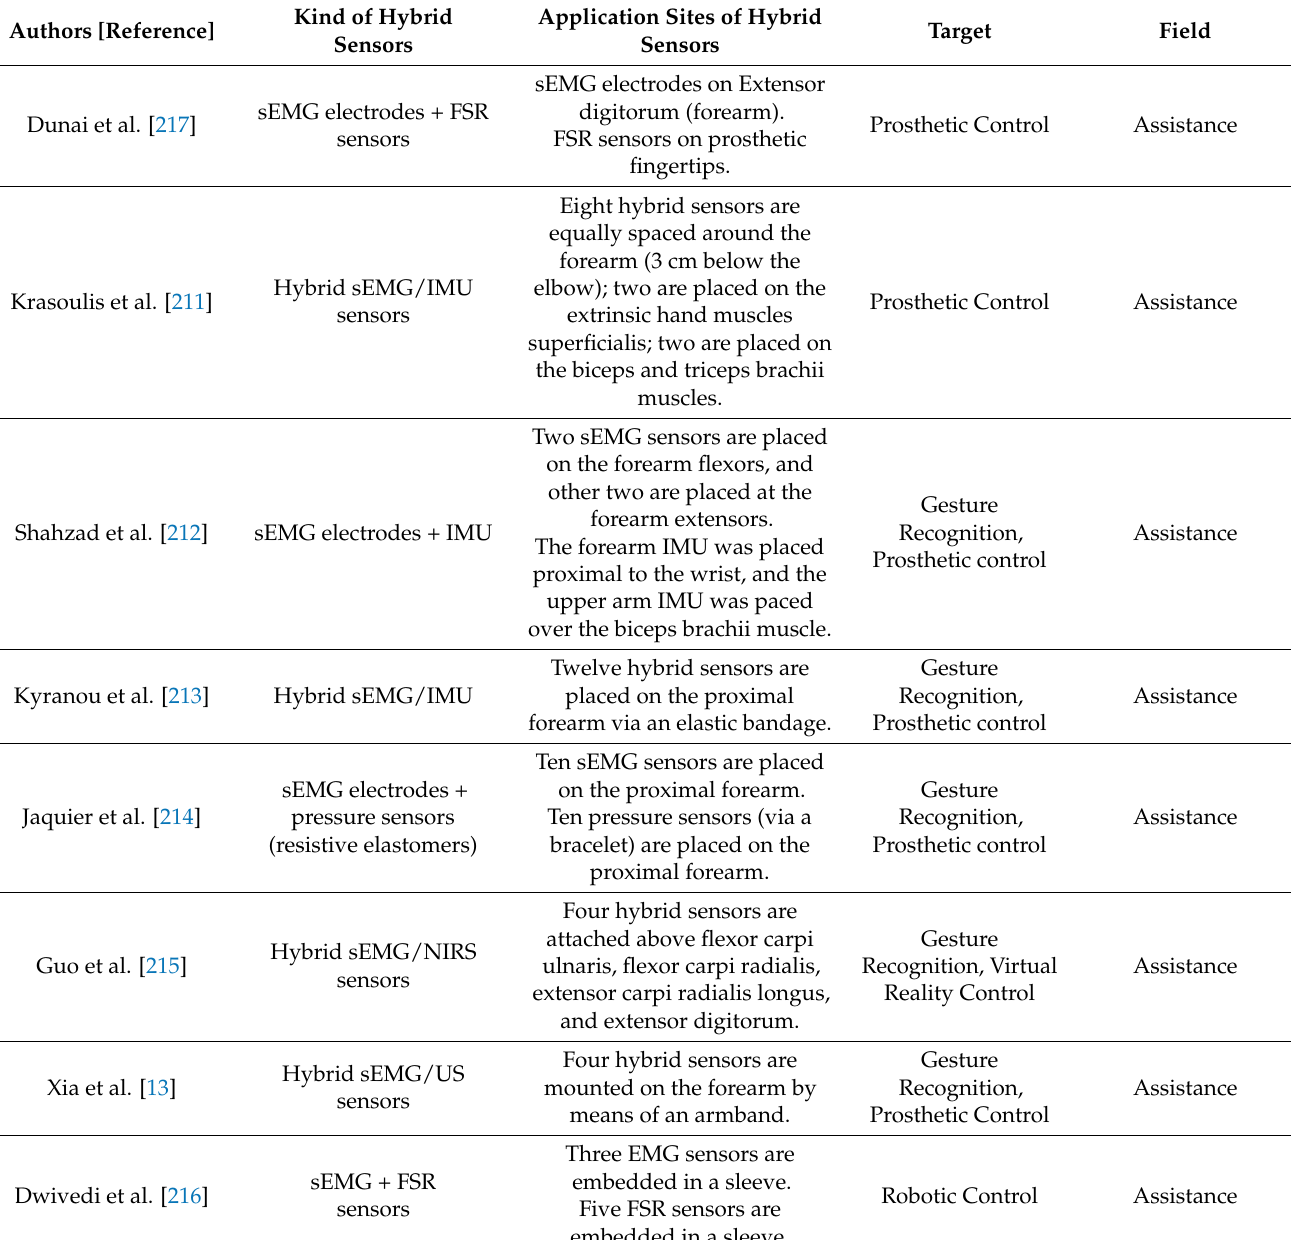
Table 14. Hybrid controls for HMIs based on Biopotentials and Mechanical Motion